Question: Draft a figure caption describing what is shown.
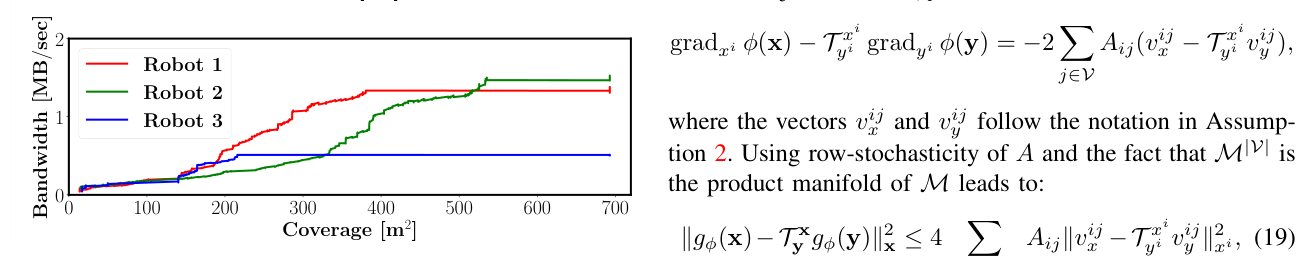
Answer: Multi-robot exploration performance metrics for the real-world experiment. Top: Evolution of the map discrepancy ϕ(h1:3) across the robot network G over time. Bottom: Band- width requirement of each robot for the distributed mapping with respect to coverage.